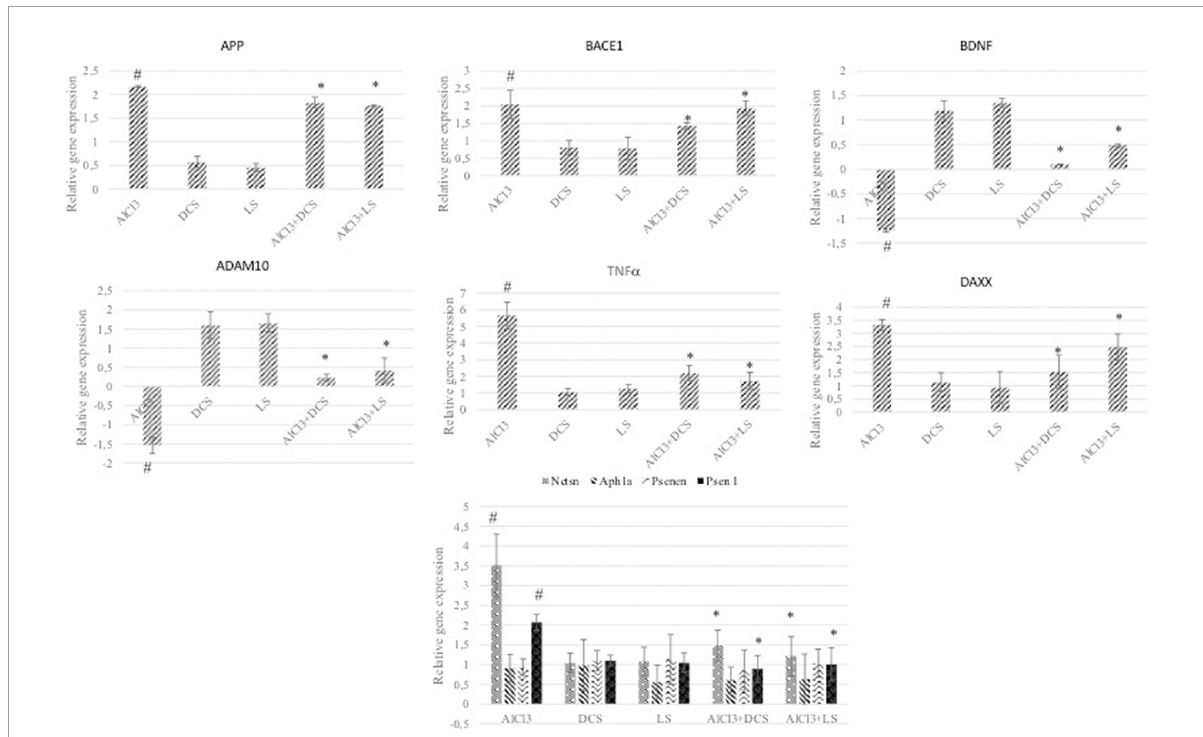
FIGURE6 The graphs represent the relative expression levels of different genes related to Alzheimer’s disease. The analyzed genes were APP, BACE1, BDNF, ADAM10, TNF α , DAXX, NCTSN, APH1A, PSENEN, and PSEN1. The data are expressed as the mean ± standard deviation. Significance difference between groups indicated by: # between control and AlCl 3 , * between AlCl 3 and treatment